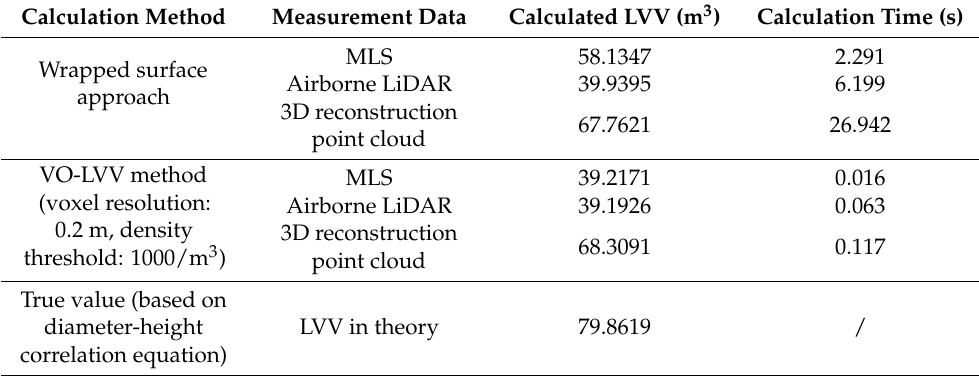
Table 4. Comparison of different LVV calculation methods (for multiple plants).